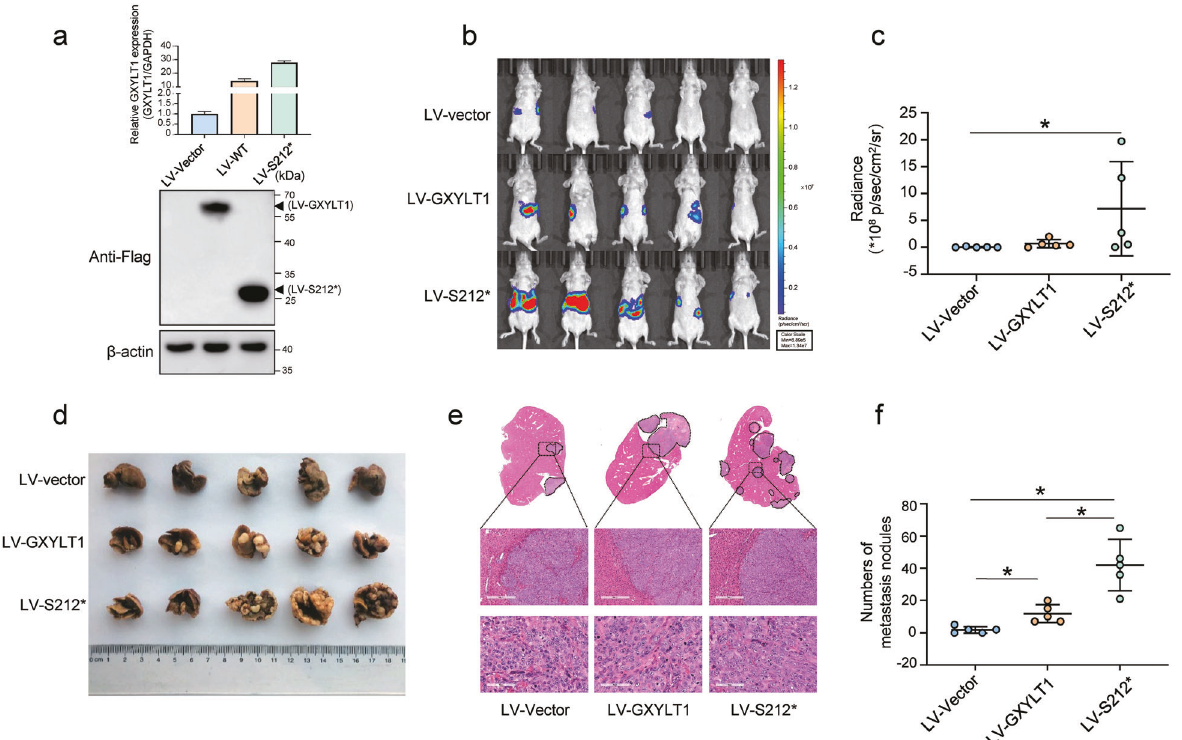
Fig. 4 GXYLT1 S212* induces increased metastatic activity in CRC than WT GXYLT1 in vivo. The spleens of mice were injected with 5 × 10 6 HCT116 cells infected with LV-control, LV-GXYLT1, or LV-S212* ( n = 5 mice per group). a GXYLT1 and GXYLT1 S212* expressions were con fi rmed in HCT116 cells stably infected with LV-GXYLT1 and LV-S212*, respectively. b Representative bioluminescence imaging of mice two weeks after implantation. c Quanti fi cation of bioluminescence imaging in the mouse liver from the indicated groups. d Representative images of liver metastatic nodules from the indicated groups. e Representative images of H&E staining in liver metastatic lesions from the indicated group. Scale bars: top, 300 μ m; bottom, 60 μ m. f Number of metastatic liver nodules from the indicated groups. Data are presented as the mean ± SD ( n = 5). * p <